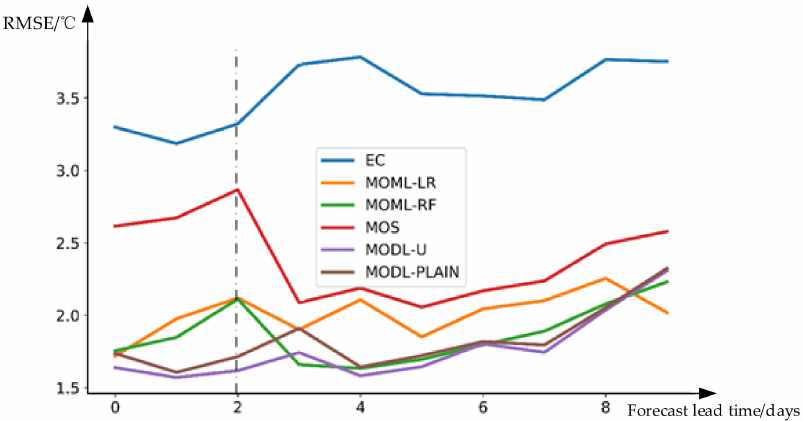
Figure 10. Forecast error’s daily root-mean-square error